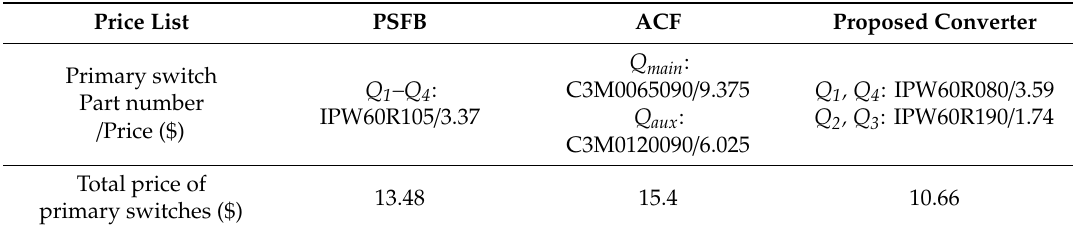
Table 2. Price comparison of the primary switches among the conventional and proposed converters. Table 3. Design Parameters.